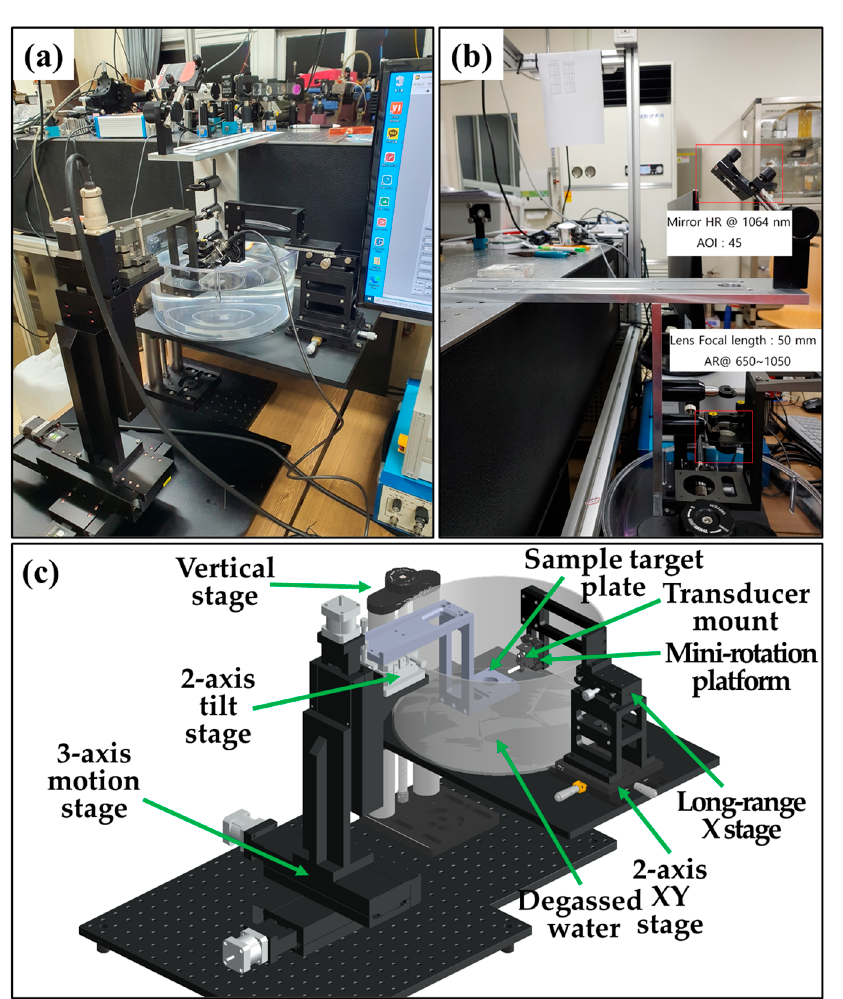
Figure 6. Implemented PA imaging system: ( a ) optical system combined with each developed area; ( b ) laser-delivery optics; ( c ) overall structure of the fabricated sample stage.